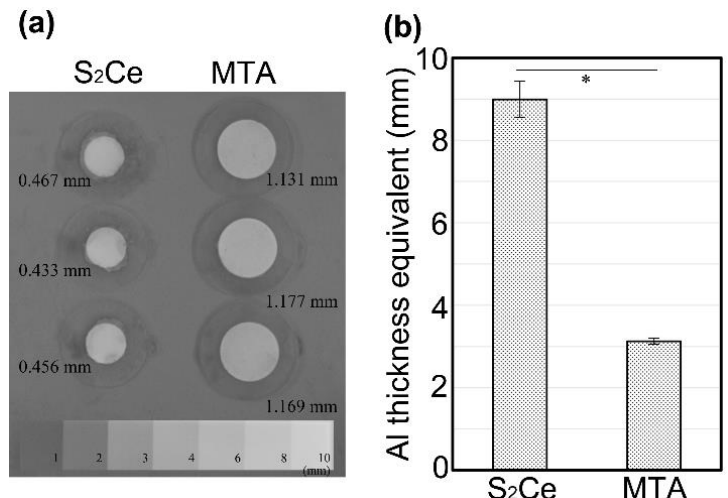
Figure 5. ( a ) Digital radiographs of S 2 Ce and MTA cement specimens and an Al step-wedge. Numbers in the photo show the thickness of the specimens. ( b ) Radiopacity values of cements are presented as Al thickness equivalent (mm). Asterisk (*) represents significant difference between S 2 Ce and MTA ( p < 0.05).